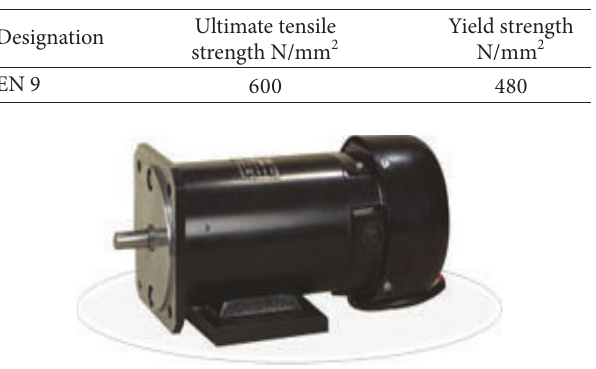
Table 1: Material selection for coupling.